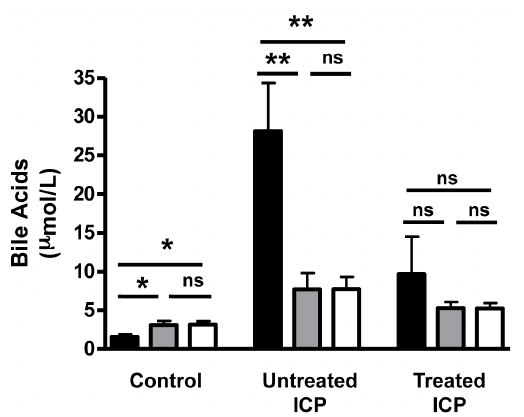
Figure 4. Transplacental total bile acid gradients in ICP cases and controls. Graphs representing the differences in the levels of total bile acids between maternal, umbilical cord artery and vein serum samples from normal (A) (n=15), untreated ICP (B) (n=7) and treated ICP (C) (n=5) pregnancies. Black bars=maternal samples, grey bars=umbilical cord vein samples, white bars=umbilical cord artery samples. * p= , 0.05, maternal total bile acid vs. cord artery total bile acid and cord vein total bile acid. ** p= , 0.005, maternal total bile acid vs. cord artery total bile acid and cord vein total bile acid. ns=not